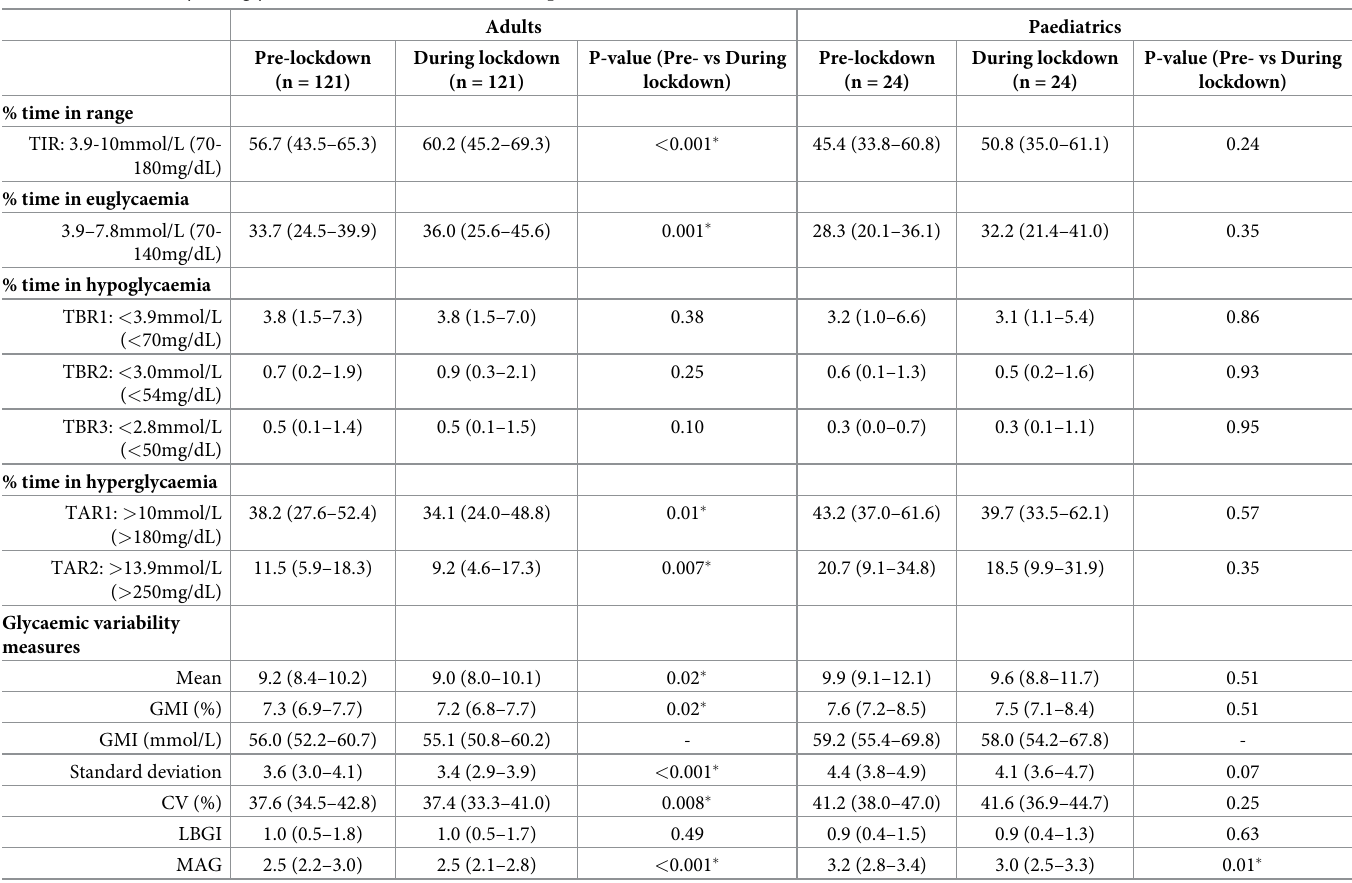
Table 2. Pairwise analysis of glycaemic outcomes in the adult and paediatric